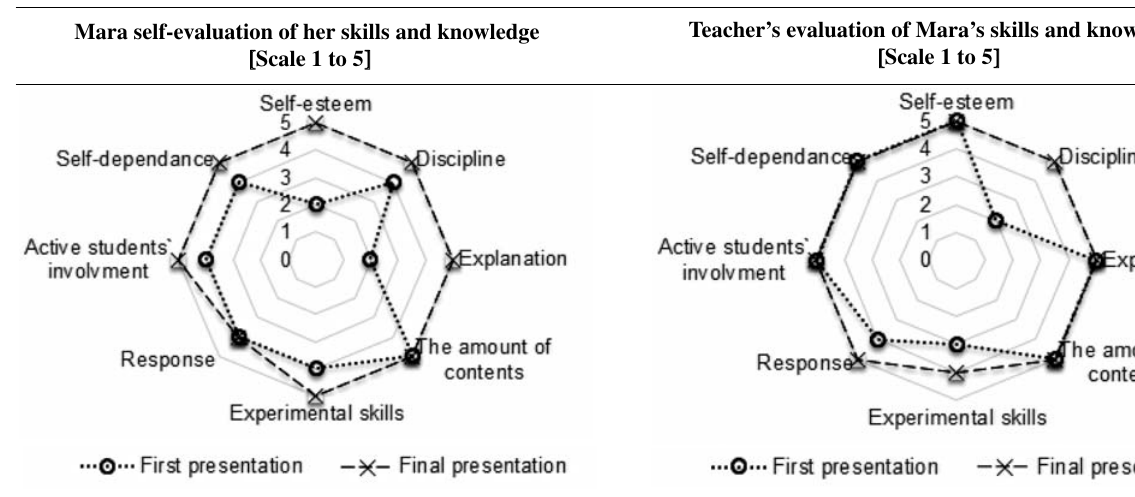
Table 6. Mara’s self-evaluation of her skills and knowledge in specific fields at her first and final presentation during their PPT in comparison with the evaluation of her school